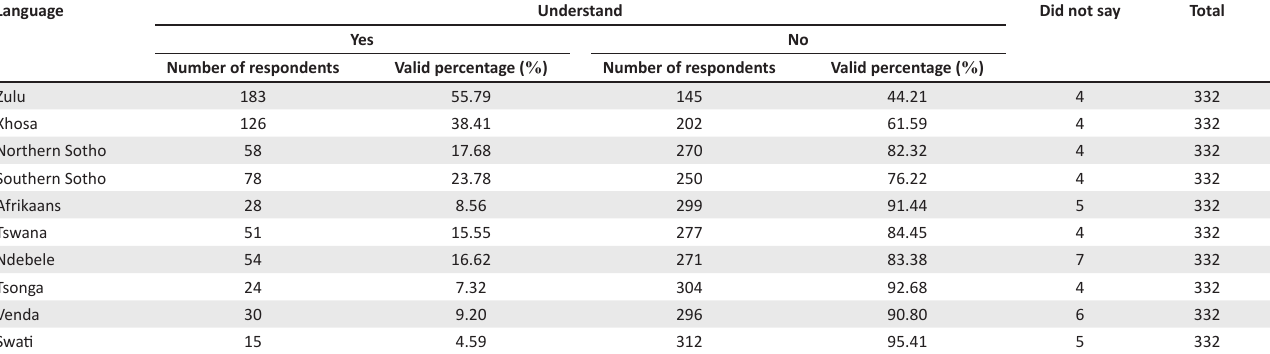
TABLE 2: Respondents who understood local languages. Language Understand Did not